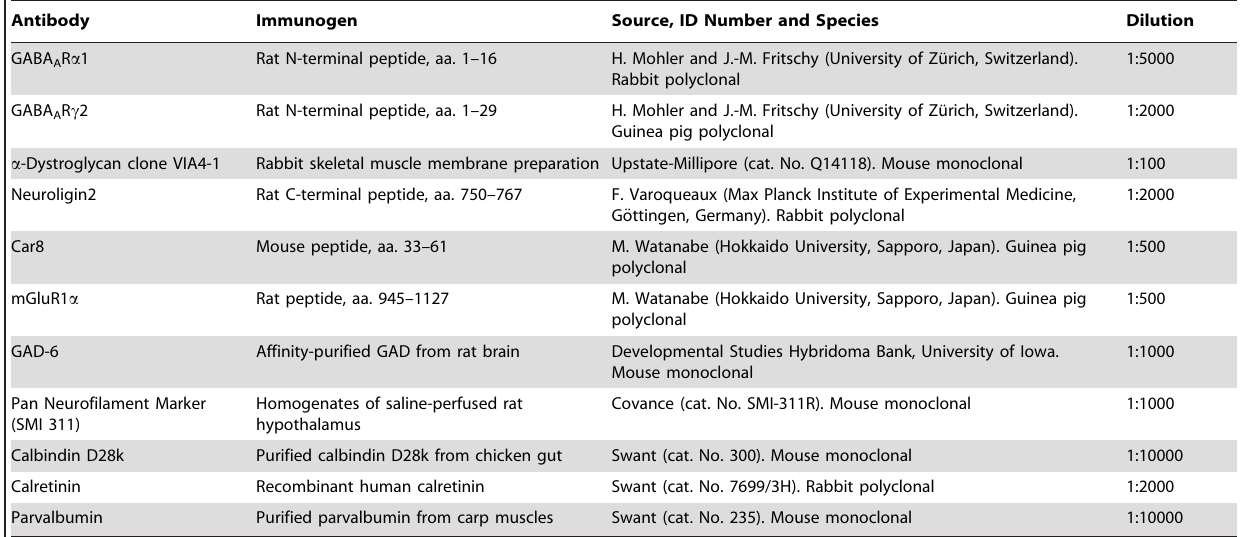
Table 1. Primary Antibodies